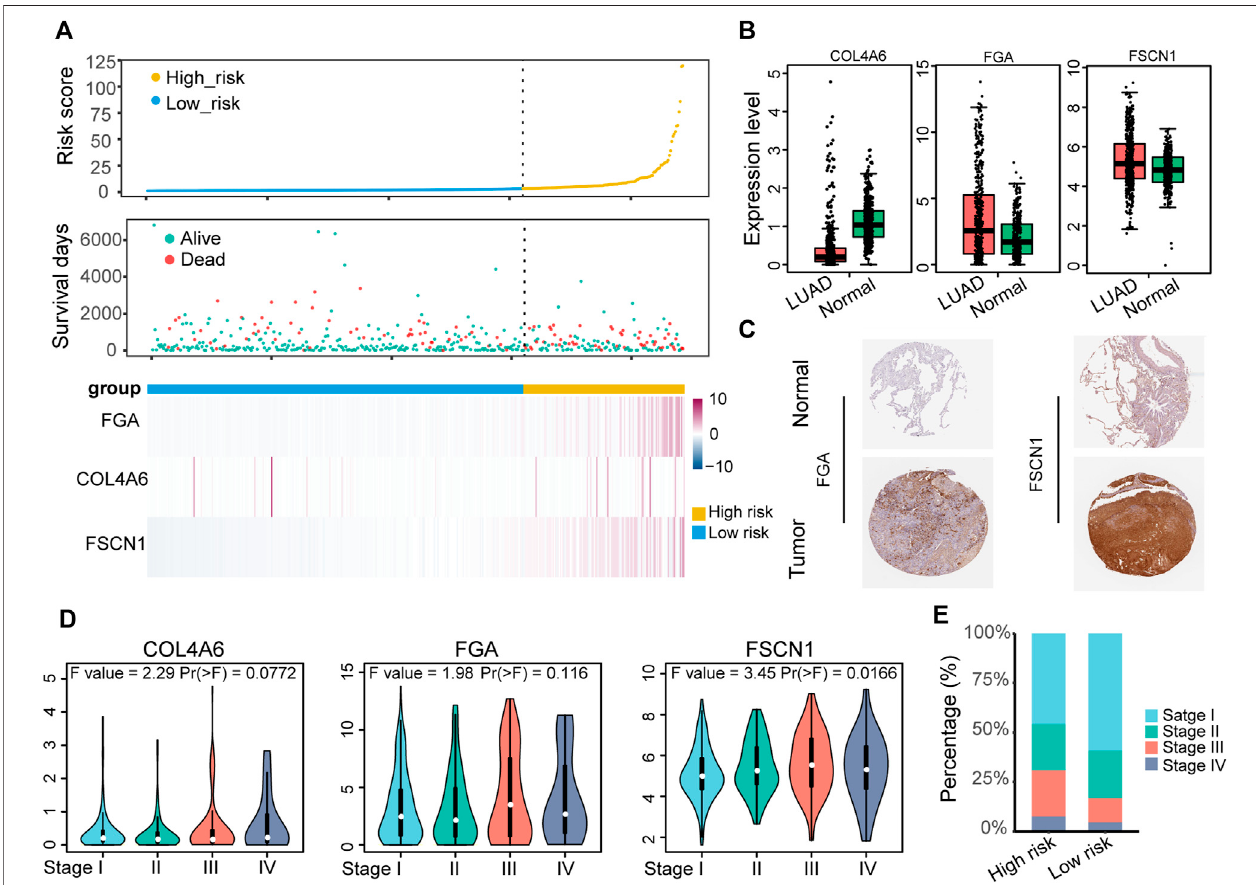
FIGURE4| Identi fi cationoftheexpressionandclinicalfeaturesunderlyingtheECMorganization-relatedprognosticsignature. (A) Thedistributionofsurvivalstatus and expression pro fi le of the three prognostic-associated ECM organization genes for the TCGA-LUAD dataset sorted by signature risk score in ascending order. (B) The expression level ofthe three signature genesin LUAD (GEPIA). (C) Immunohistochemical analysis ofthe protein expression ofFGA and FSCN1in LUAD and normal lung tissues in the HPA database. (D) Expression level of three signatures in different TNM stages of LUAD. (E) Histogram showing the distribution of TNM stages between low-risk and high-risk